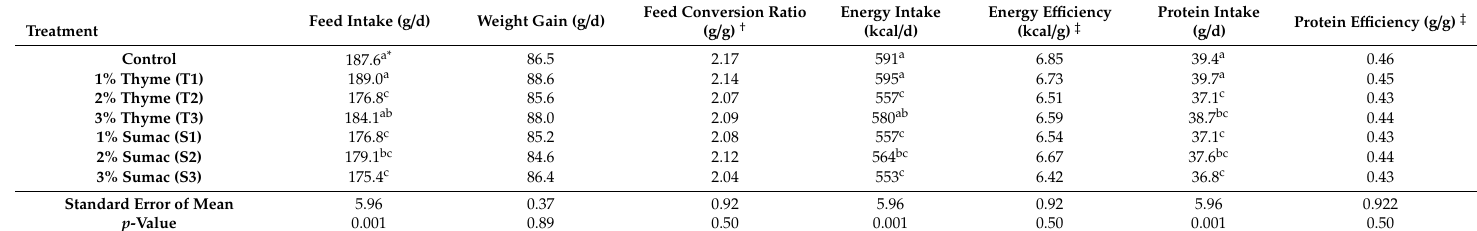
Table 2. Performance mean ( ± SEM) of Ross 308 broilers at finisher period (29–42 days) of age fed diets containing 0, 1, 2, and 3% thyme (T3) and sumac in the diet powders from days 29–42.